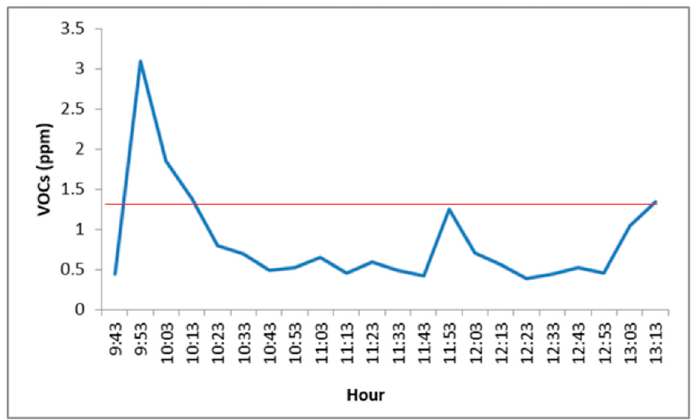
Figure 3. VOC concentrations (ppm) in the doctor’s consultation. (Red line: Guideline Value).